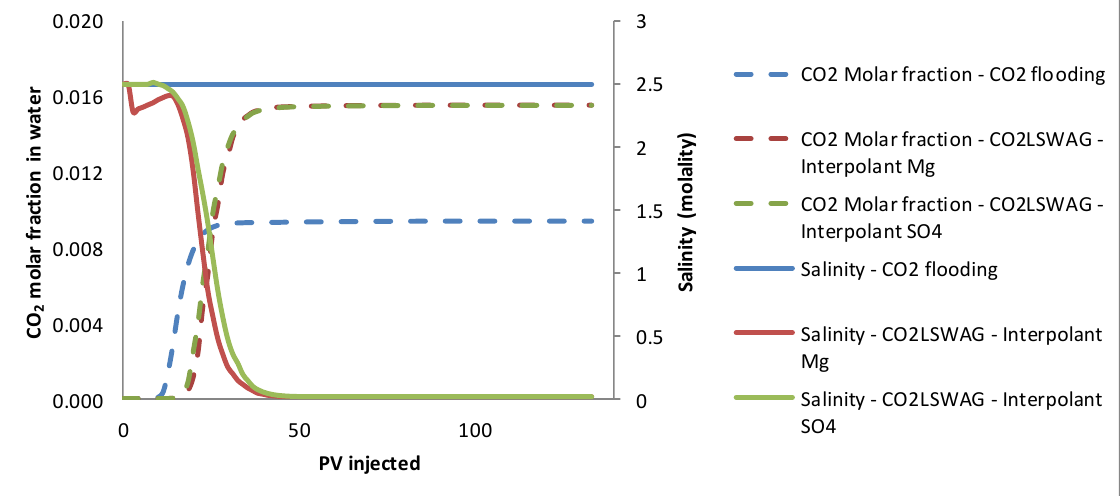
Figure 13. Results of CO 2 molar fraction and salinity of the effluent for continuous CO 2 injection and CO 2 -LSWAG considering Mg and SO 4 as ion interpolants.